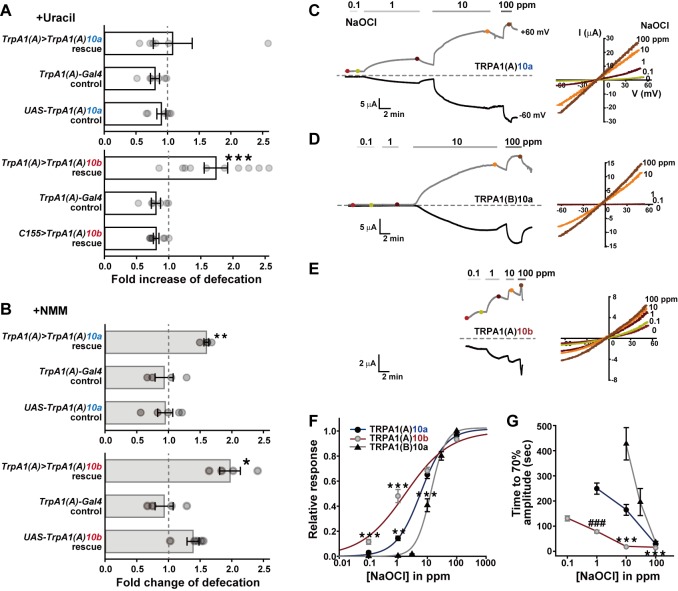
The TRPA1(A)10b isoform is the HOCl receptor essential for uracil-evoked defecation.A Rescue of the defect in uracil-dependent defecation of TrpA1ins animals by expressing TrpA1(A) cDNA with either exon10a (TrpA1(A)10a) or exon10b (TrpA1(A)10b) in TrpA1(A)-Gal4 cells (n = 6–10). Expression of TrpA1(A)10b by EEC-expressing TrpA1(A)-Gal4 but not pan-neuronal c155-Gal4 restored uracil-dependent defecation in the TrpA1ins animal (Lower), while TrpA1(A)10a expression in TrpA1(A)-Gal4 EECs did not (Upper). B Rescue of the defect in NMM-dependent defecation of TrpA1ins mutants by the two alternative TrpA1(A) isoforms (n = 4–5). The NMM-mediated defecation was rescued by expressing TRPA1(A)10a in TrpA1(A)-Gal4 EEC cells, although uracil-dependent defecation was not. C-E Representative dose dependence (Left) and current-voltage relationship (Right) of NaOCl responses in Xenopus oocytes heterologously expressing indicated isoforms. Note that the time scales and dose sequences are set identical for simple comparison of activation kinetics. F Normalized dose dependences of TRPA1 isoforms averaged from the results at -60 mV in C-E panels (n = 4–10). TRPA1(A)10b show more sensitive response to NaOCl than TRPA1(A)10a or TRPA1(B). Current amplitudes at varying doses of NaOCl was normalized with respect to that at 100 ppm. The data were fitted to Hill equation to determine EC50s. G Time to 70% of the steady state current amplitude induced at each NaOCl concentration was measured for indicated TRPA1 isoforms for activation kinetics comparison of macroscopic NaOCl currents (n = 5–9, -60 mV). Mean ± SEM shown. *: p<0.05, **: p<0.01, ***: p<0.001, Tukey test. ###: p<0.001, Student’s t-test. See also S9 Fig for further functional characterization data of fly and human TRPA1s in oocytes, and for HOCl- or NMM-elicited action potential responses in sugar cells ectopically expressing fly TRPA1 isoforms.